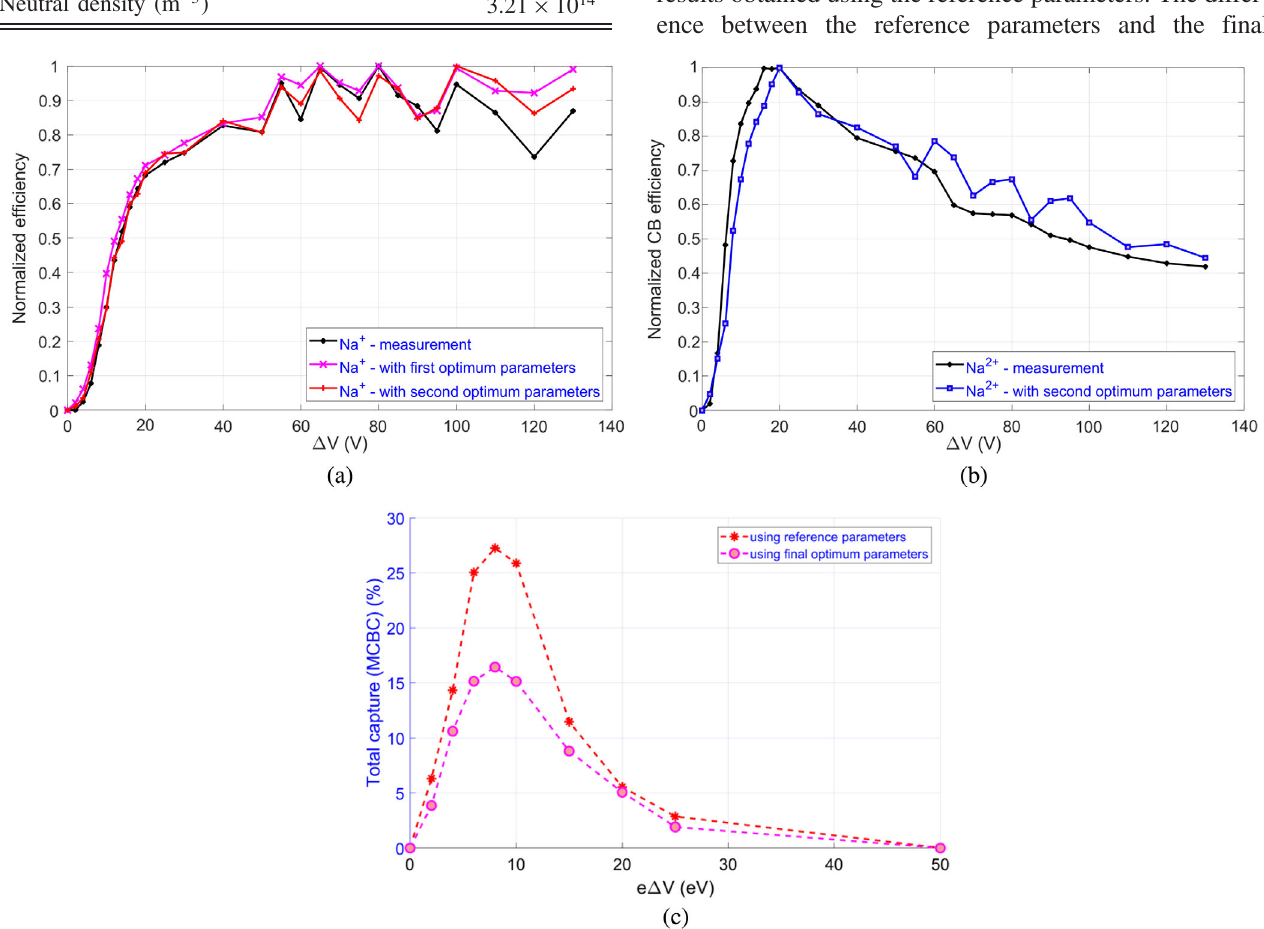
FIG. 10. (a) Comparison of experimental and simulated Na þ Δ V curves acquired using final optimum plasma parameters. (b) Comparison of experimental and simulated Na 2 þ Δ V curves acquired using final optimum plasma parameters. (c) Proportion of 1 þ ions captured as a function of e Δ V using the initial and final plasma